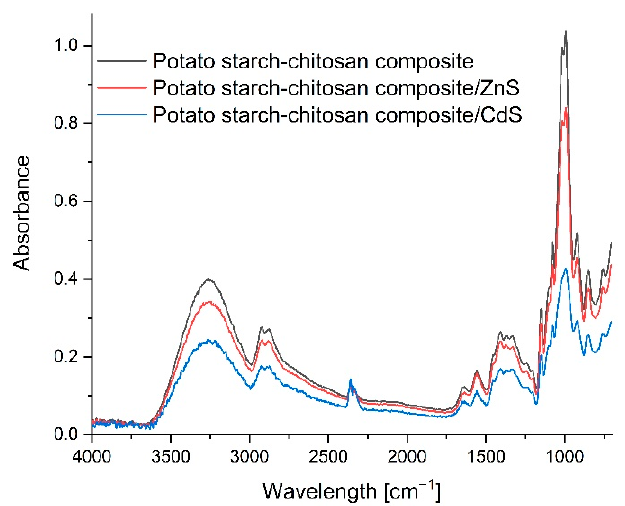
Figure 4. FTIR spectra of the control film, ZnS quantum dot film, and CdS quantum dot film.